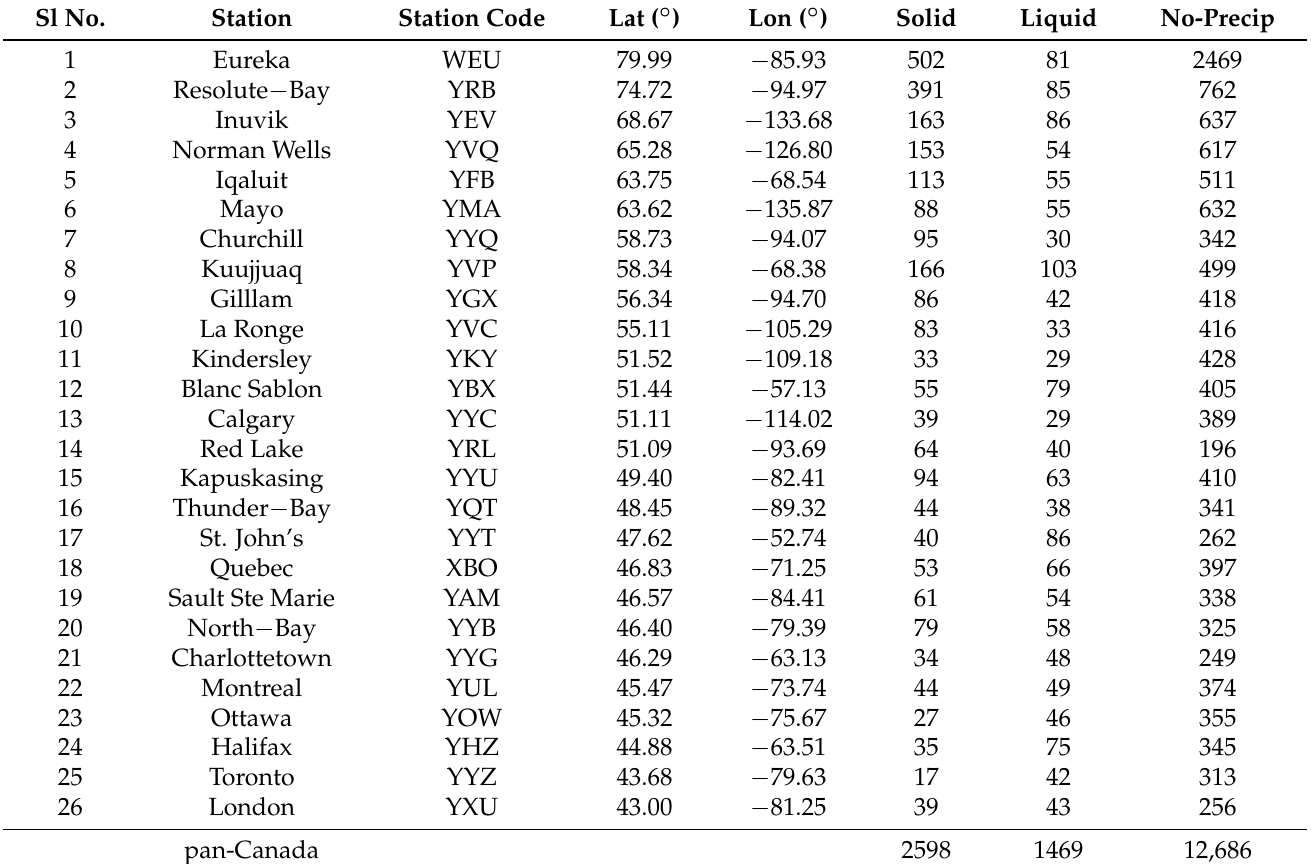
Table 3. Table showing the geographical coordinates of stations considered in this study as shown in Figure 1, station codes and number of solid, liquid and non-precipitating CloudSat overpasses (sample size) obtained after matching CloudSat and ECCC weather data Sl